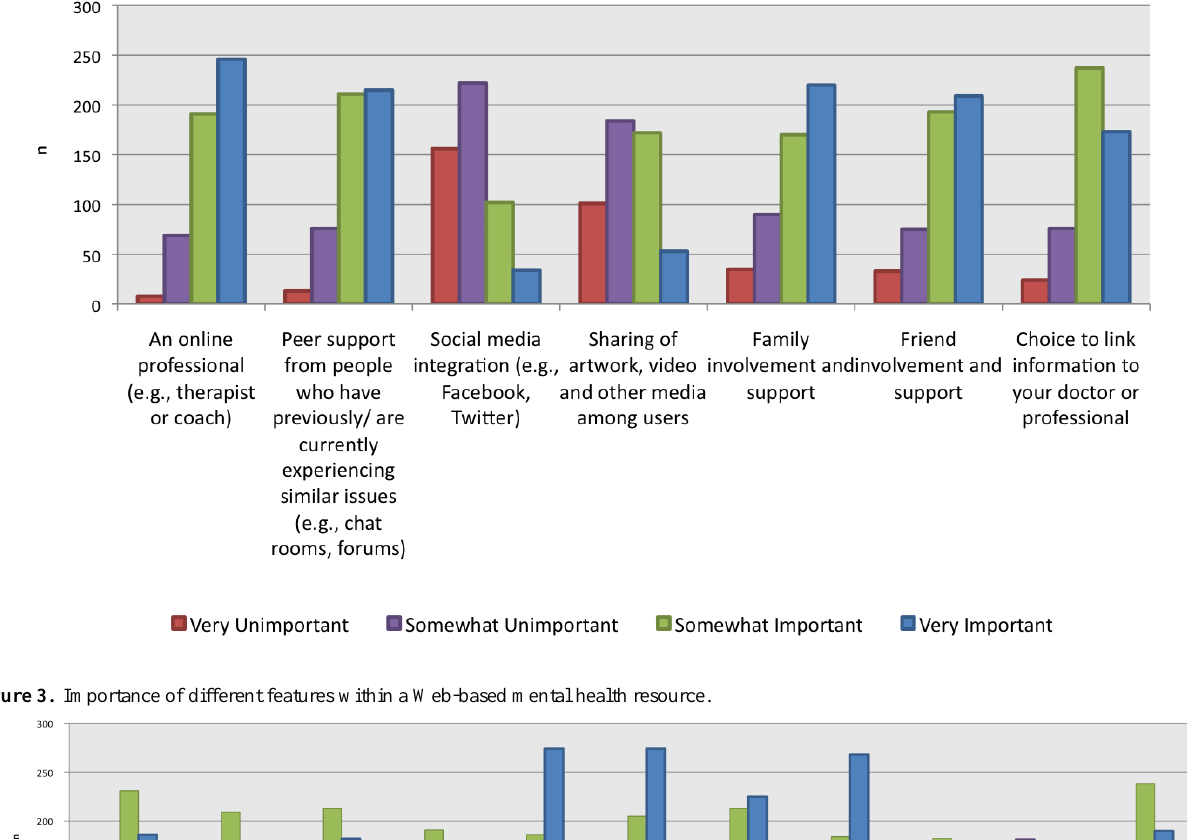
Figure 2. Importance of contact with different supports in a Web-based mental health resource.